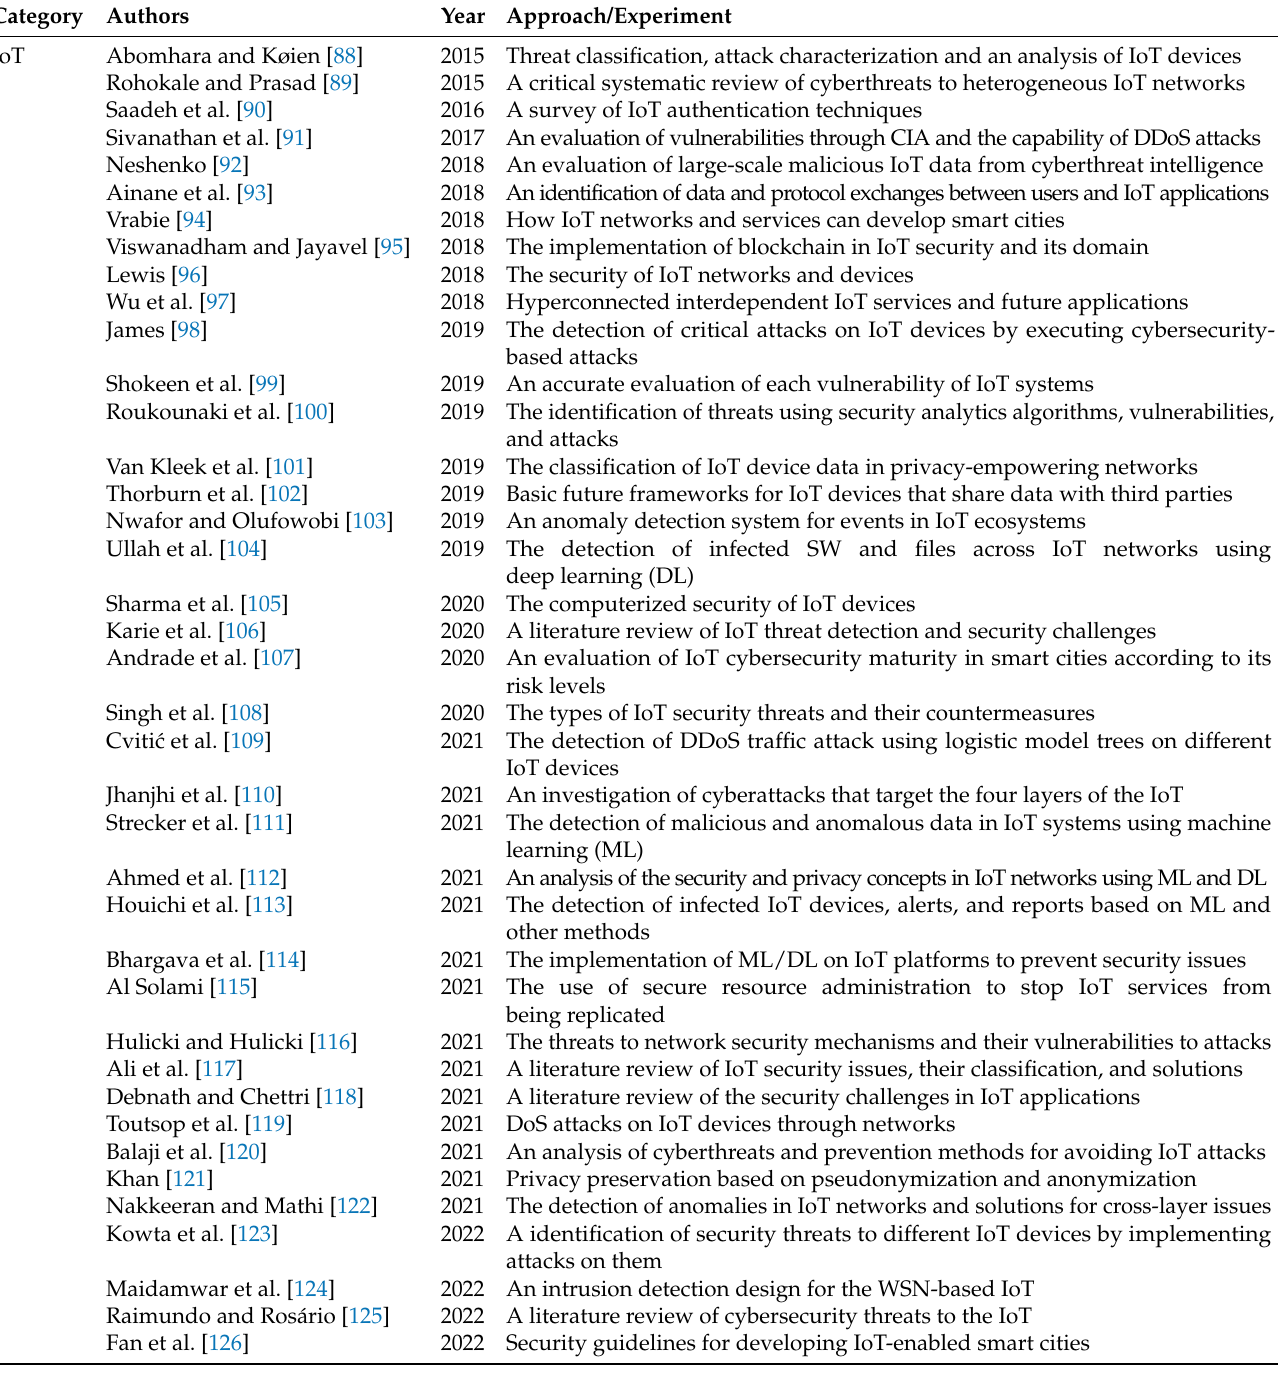
Table 3. A summary of the approaches and experiments presented in existing IoT cybersecurity